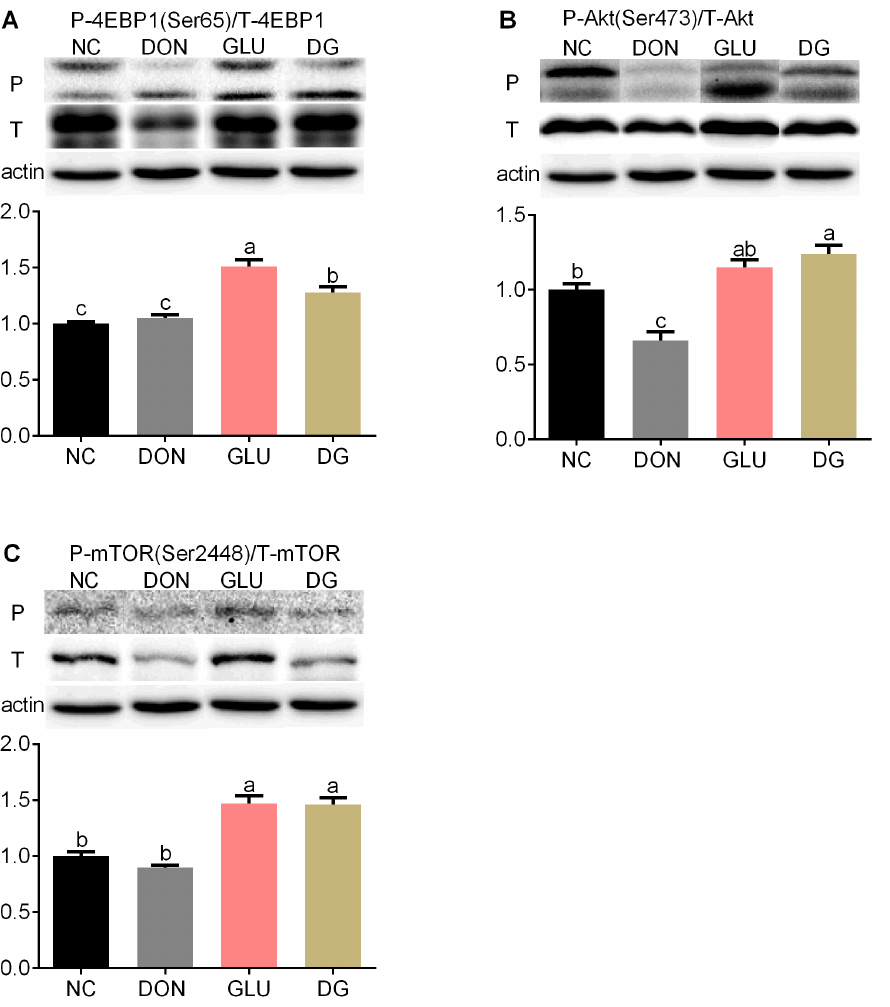
Figure 7. Activation of mTOR in ileum. (Up) Representative western blots of total 4EBP1(T-4EBP1), phosphorylated 4EBP1 (Ser65) (P-4EBP1), total Akt (T-Akt), phosphorylated Akt (Ser473) (P-Akt), total mTOR (T- mTOR), phosphorylated mTOR (Ser2448) (P- mTOR) in ileal of piglets fed the various dietary treatments. b -actin was the loading control. (Down) Quantification by image analysis of 4EBP1, Akt and mTOR phosphorylation. Dietary treatments were NC, an uncontaminated basal diet, DON, the basal contaminated with 4 mg/kg deoxynivalenol, GLU, uncontaminated basal diet with 2% (g/g) glutamic acid supplementation, and DG, deoxynivalenol-contaminated (4 mg/kg) basal diet with 2% (g/g) glutamic acid supplementation. n=7 for treatments. (P , 0.05) in the ileum (Figure 7) and 203.2% (P , 0.05) in the jejunum (Figure 8), the phosphorylation of mTOR by 61.5% in the ileum (Figure 7) and 33.2% in the jejunum (Figure 8), compared with the DON diet.